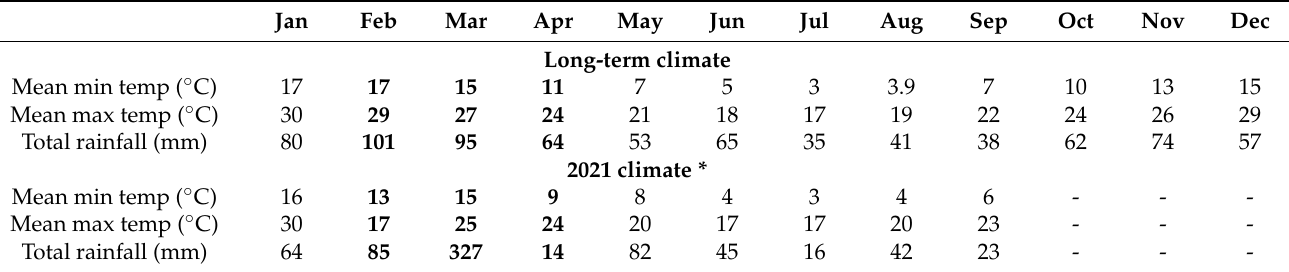
Table 1. Climate of Camden, NSW. Long-term maximum and minimum temperature data are based on averages of 1971–2021, while rainfall is based on data for 1943–2021. (Source: Bureau of Meteorology) [18].